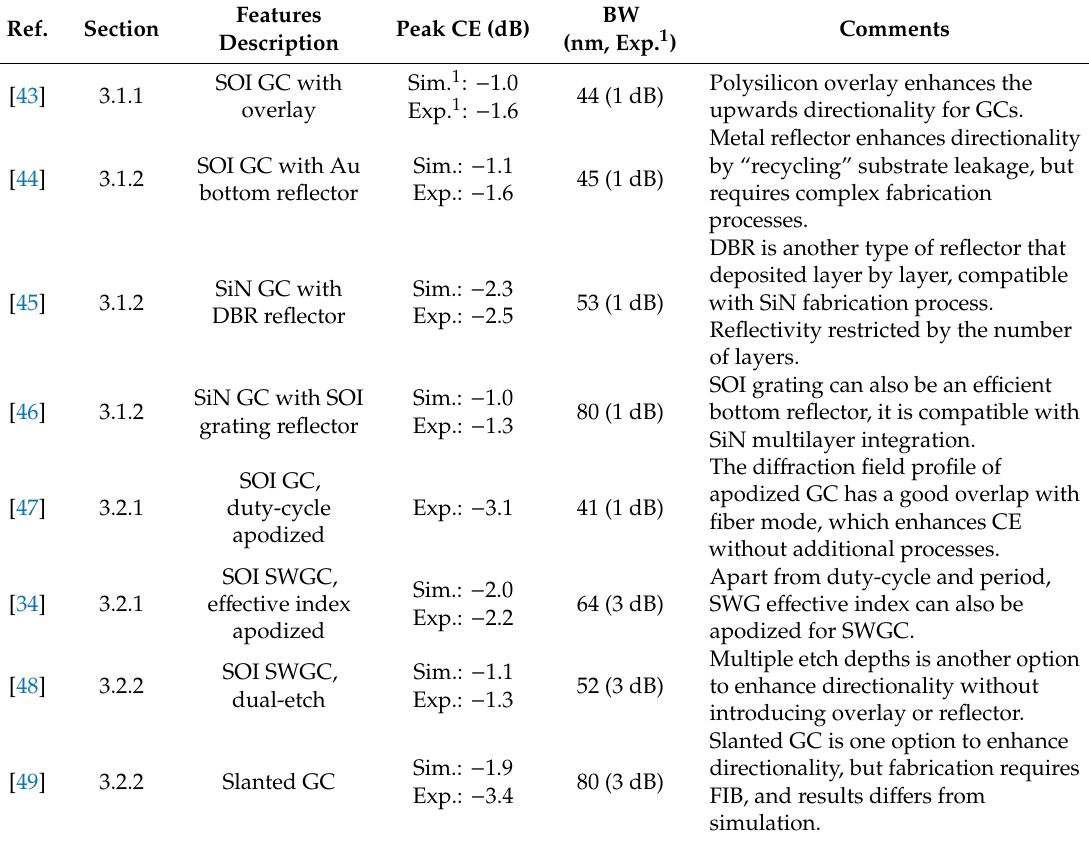
Table 1. Comparison between some grating couplers (GCs) with features reviewed in Section 3. Ref.